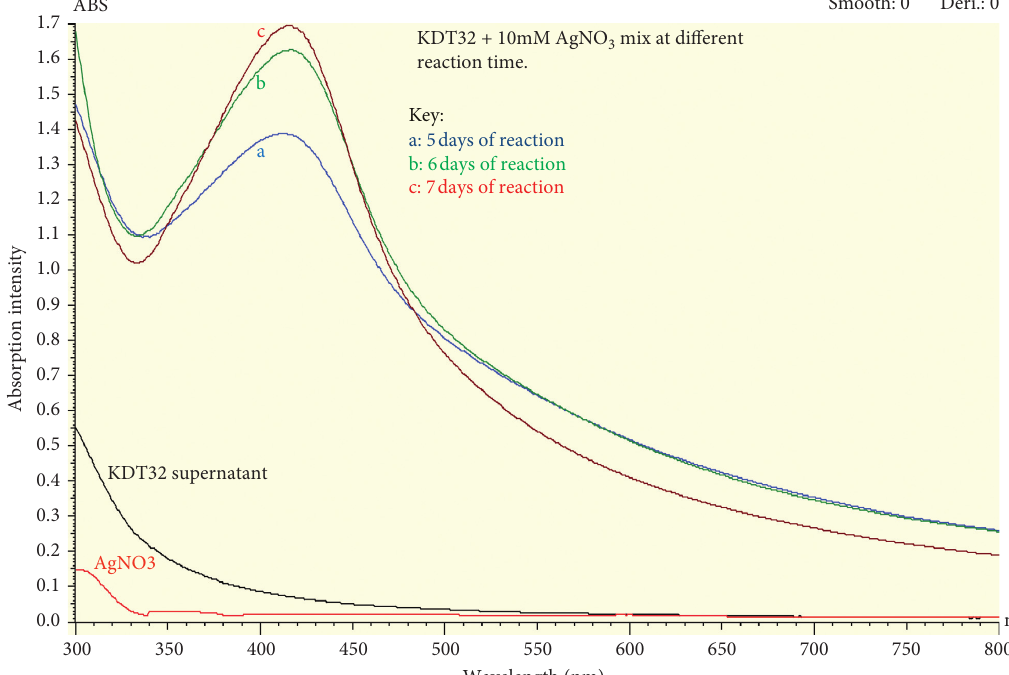
Figure 2: Comparison of the KDT32-AgNPs absorption intensity at maximally centered peak wavelength at different reaction days.